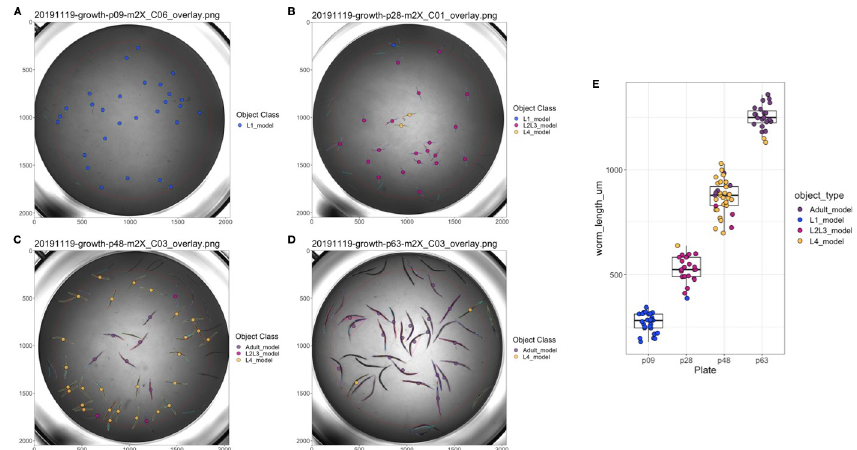
Fig 5. easyXpress applied to C . elegans growth data. A subset of well images acquired during C . elegans development displaying easyXpress processed data are shown here. Images taken at (A) 9 hours indicating the L1 stage, (B) 28 hours indicating the L2/L3 stage, (C) 46 hours indicating the L4 stage, and (D) 63 hours indicating the adult stage were analyzed with CellProfiler using four worm models. The easyXpress workflow was then used to process and visualize the data. The length of each object identified after processing is shown in